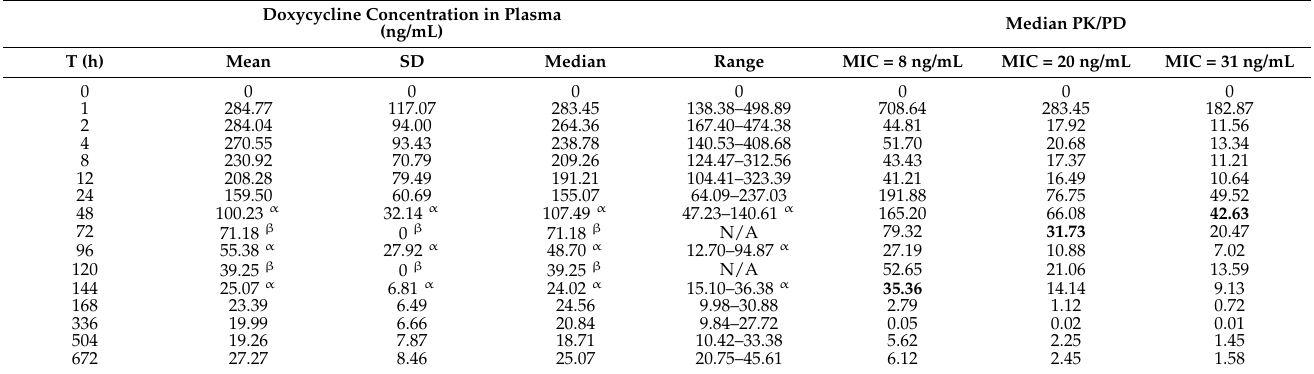
Table 3. Mean and standard deviation (SD), median, and range of the doxycycline plasma concentrations when koalas were administered doxycycline at 5 mg/kg via subcutaneous injection (diluted at 50:50 with saline), once a week for four weeks. Median PK/PD ratios of the six koalas with chlamydiosis at various time points over four weeks (672 h) are also provided.